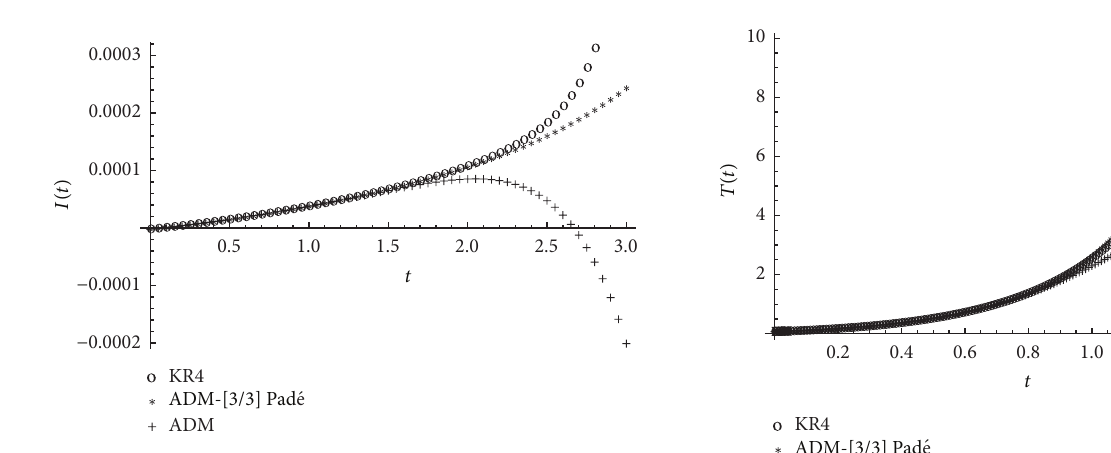
Figure 2: Curves of KR4, ADM-[3/3] Pad´e approximation, and ADM for 𝐼(𝑡) .